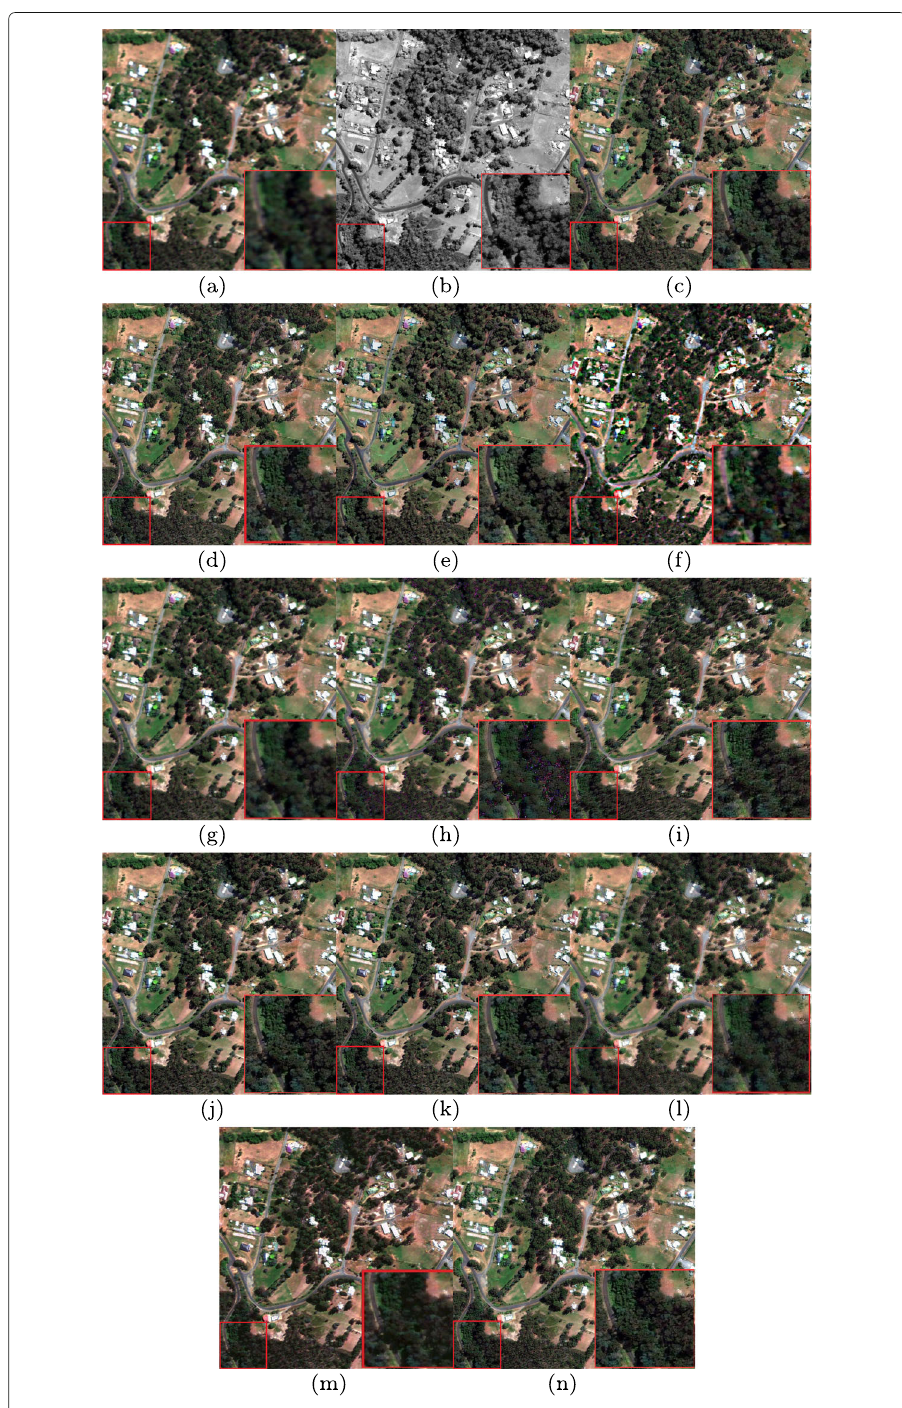
Fig. 11 Fusion results of the real GeoEye-1 dataset. a Upsampled MS image (1024 × 1024). b PAN image (1024 × 1024). c IHS method. d AIHS method. e PCA method. f BDSD method. g PRACS method. h